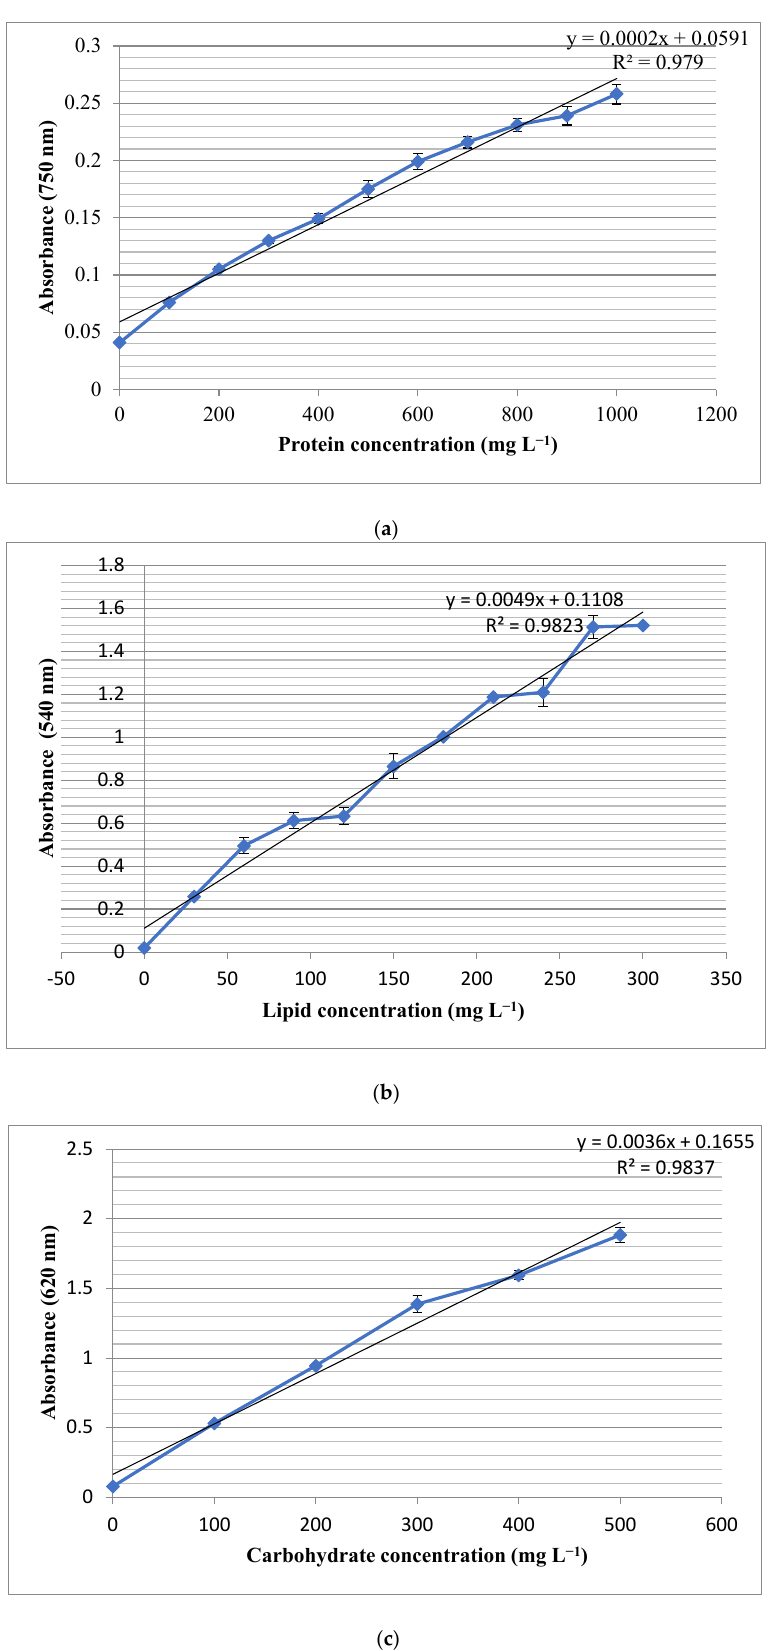
Figure 2. Standard curves and R 2 values for ( a ) protein, ( b ) lipid and ( c ) carbohydrate determination. The bars on each dot represent standard deviation of three experiment. There was a total of 0.12 mg mg − 1 of nucleic acid and other undetermined components in the lyophilized biomass (Figure 3).